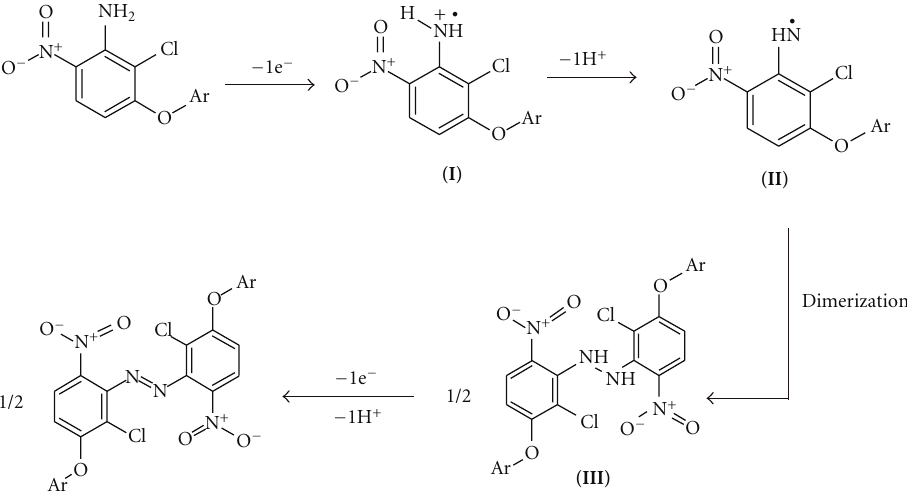
Scheme 3: Mechanism of the anodic oxidation of aclonifen Ar : C 6 H 5 .